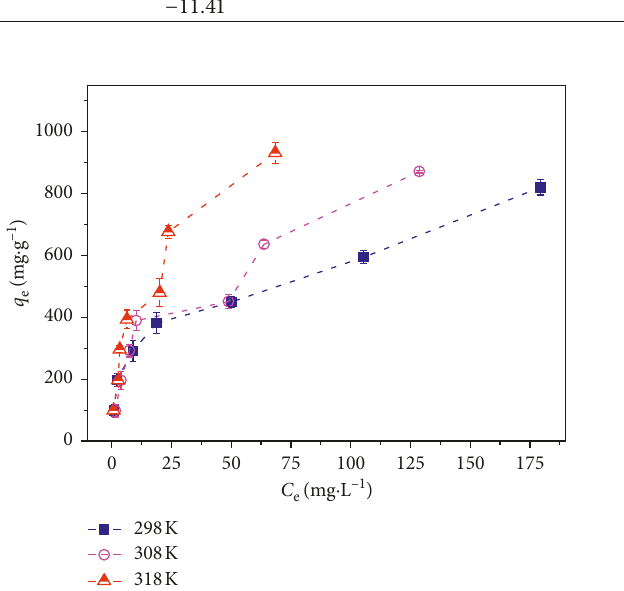
Figure 9: Adsorption isotherm diagram.